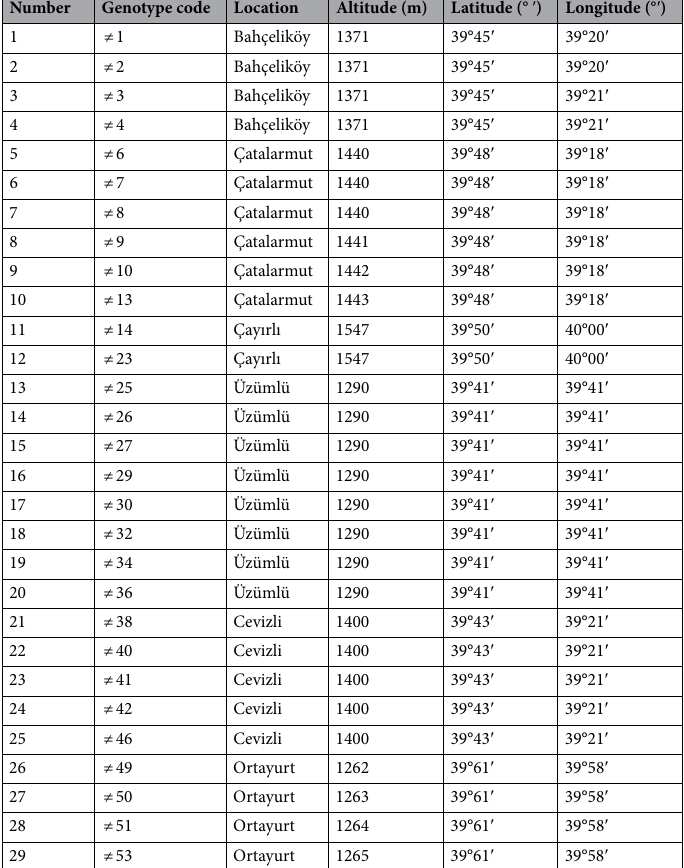
Table 1. Coordinate information of the regions where pumpkin genotypes were